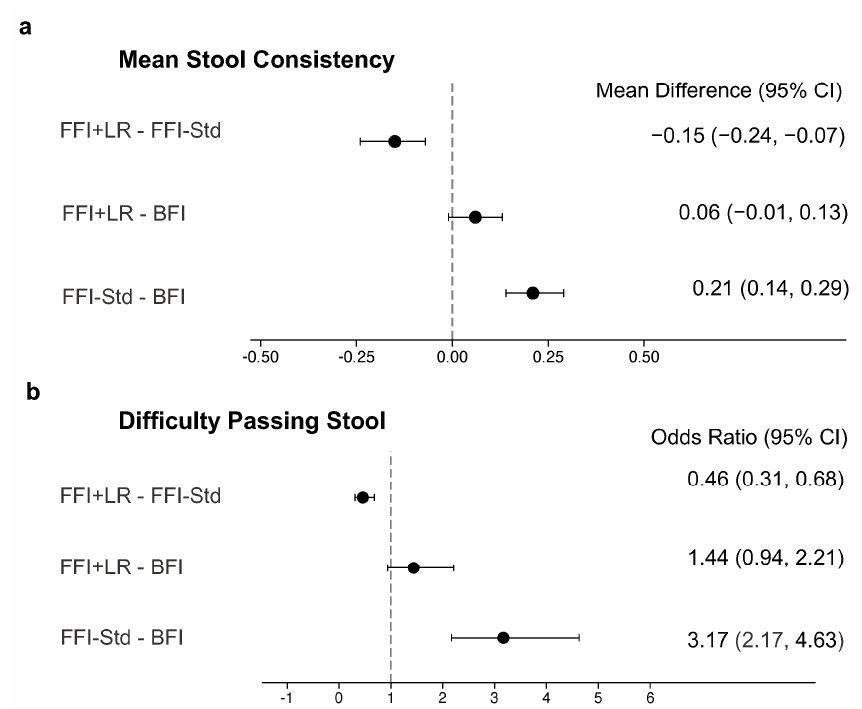
Figure 2. Comparisons of stool characteristics between the feeding groups, including mean differences for stool consistency ( a ) and odds ratios for difficulty passing stool ( b ). The vertical line shows the reference value for each measure. Stool consistency and difficulty in passing stool were measured using the Feeding Practice and Gut Comfort Questionnaire, which collected consistency for each stool and number of stools difficult to pass in the 24 h prior to the administration of the questionnaire. Stool consistency was measured using a 4-point scale (1 = Watery, 2 = Loose, 3 = Formed, 4 = Hard). Stool consistency was modeled using ANCOVA and difficulty passing stool was modeled using logistic regression. In addition to feeding group, models were further adjusted for study site (only for stool consistency), infant age, sex, delivery type, history of gastrointestinal disease in parents and mother’s education. BFI—Breastfed infants; FFI + LR—Infants fed formula with L. reuteri ; FFI-Std—Infants fed standard formula without any probiotic or prebiotic. n = 760 in BFI; n = 501 in FFI-Std; n = 470